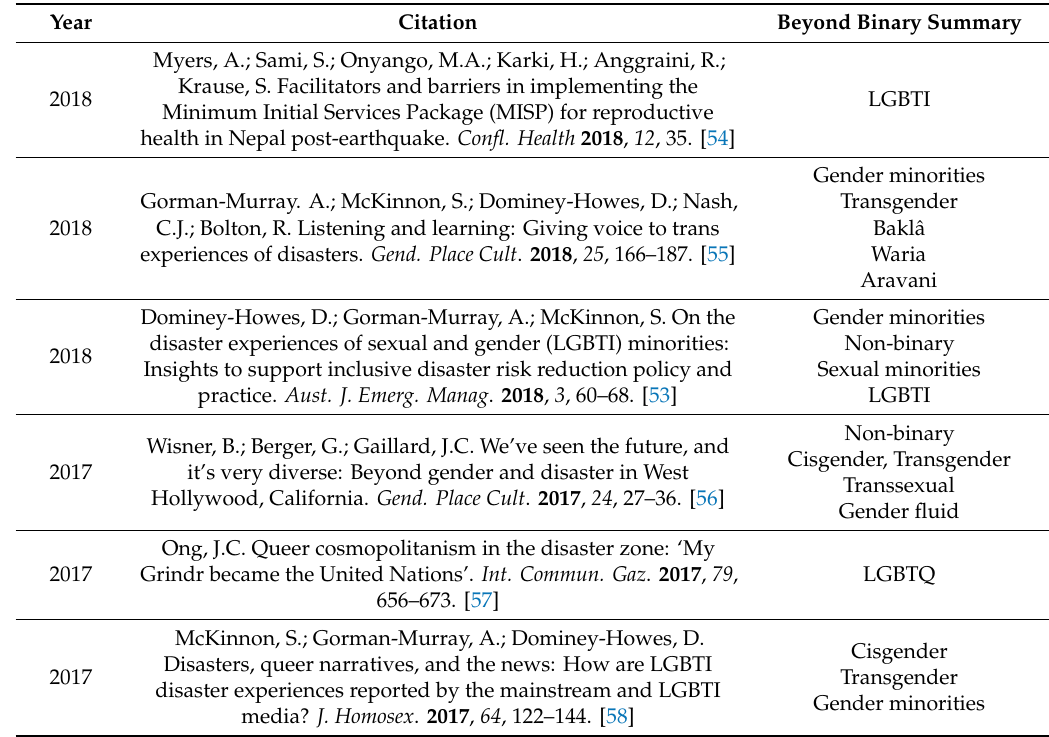
Table 2. Rapid review: papers referring to minority genders outside of the binary ( n =